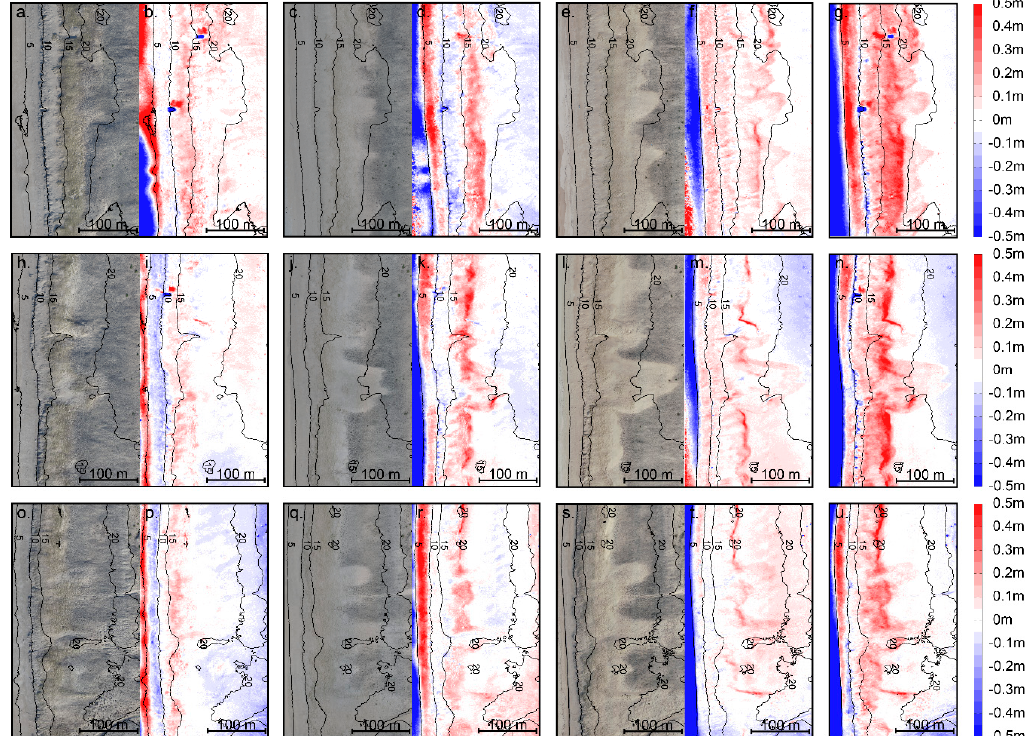
Figure 7. Beach-dune morphological changes zoomed onto the areas shown by the black squares in Figure 6. ( a – g ) northern area; ( h – n ) central area; ( o – u ) southern area. Orthophotos of Truc Vert beach generated with DP2 on ( a , h , o ) 19 December 2017, ( c , j , q ) 23 January 2018, and generated with DP4P on ( e , l , s ) 13 March 2018, are shown with the corresponding DSM difference plot between 9 October 2017 and 19 December 2017 ( b , i , p ), 19 December 2019 and 23 January 2018 ( d , k , r ) and 23 January 2018 and 13 March 2018 ( f , m , t ). The right-hand panels ( g , n , u ) shows the DSM difference plot for the entire study period between 9 October 2017 and 13 March 2018. The colorbar indicates the elevation difference in meters.